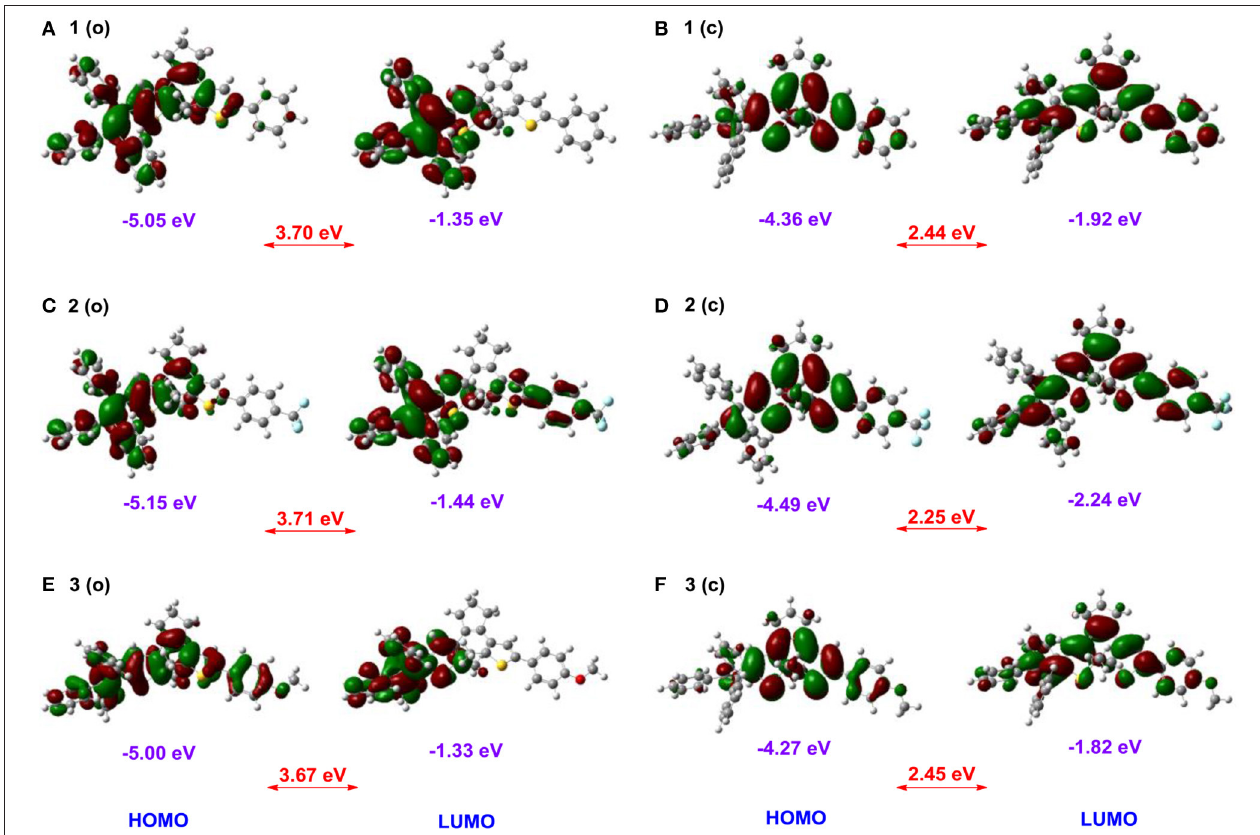
FIGURE 6 | Frontier molecular orbital profiles of dithienylethenes 1–3 based on DFT calculations at the B3LYP/6-31G* level by using the Gaussian 09 program, (A) ring-open isomer 1 (o); (B) ring-closed isomer 1 (c); (C) ring-open isomer 2 (o); (D) ring-closed isomer 2 (c); (E) ring-open isomer 3 (o); (F) ring-closed isomer 3